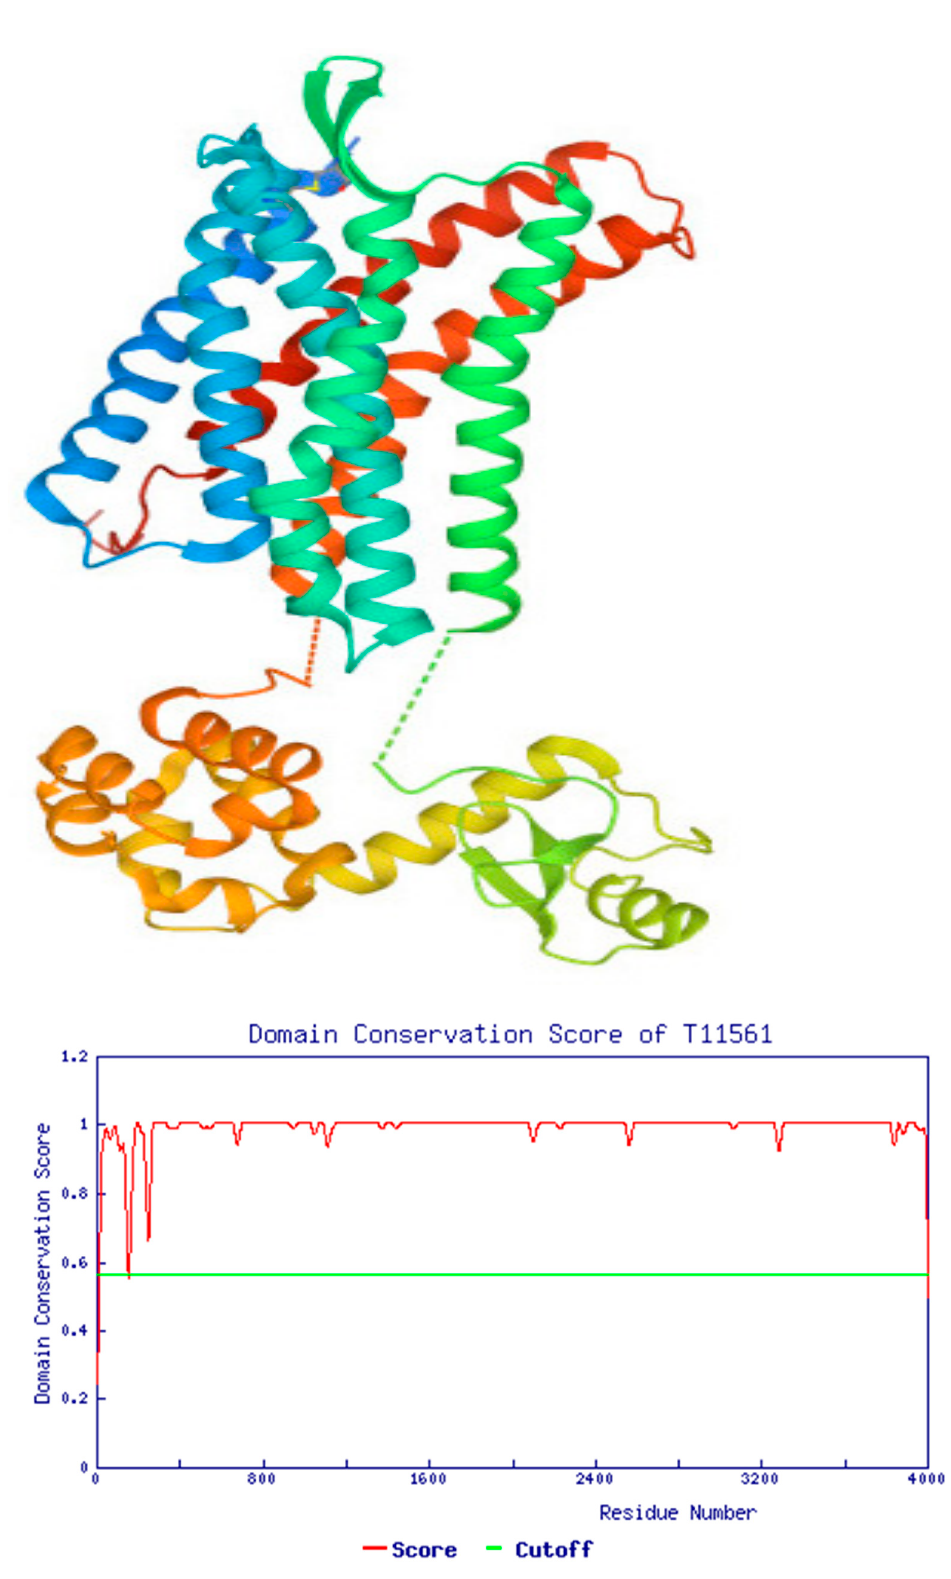
Figure 3. The crystal structures of human proteins and conservation analyses were used to simulate the homology of the CXCR4 structure. The evolutionary rate of a site is reflected in the conservation score at that location.